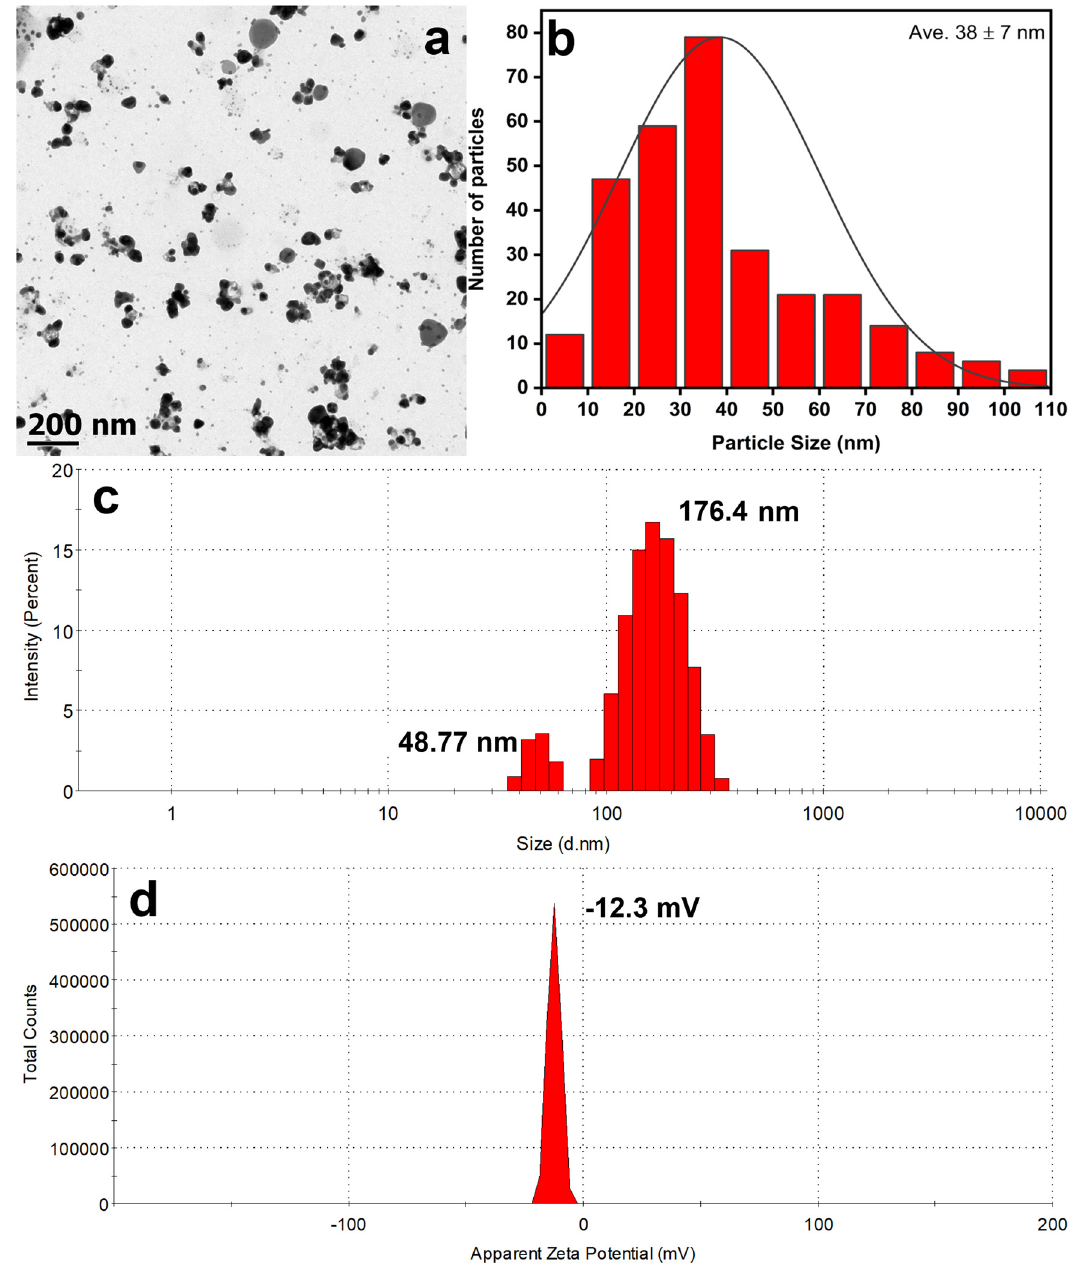
Figure 2: ( a ) AgNPs morphological study using TEM, which is spherical. ( b ) Histogram of particle size distribution calculated using ImageJ. ( c ) Hydrodynamic diameter of AgNPs shown in a bimodal distribution. ( d ) Zeta potential of as - synthesized